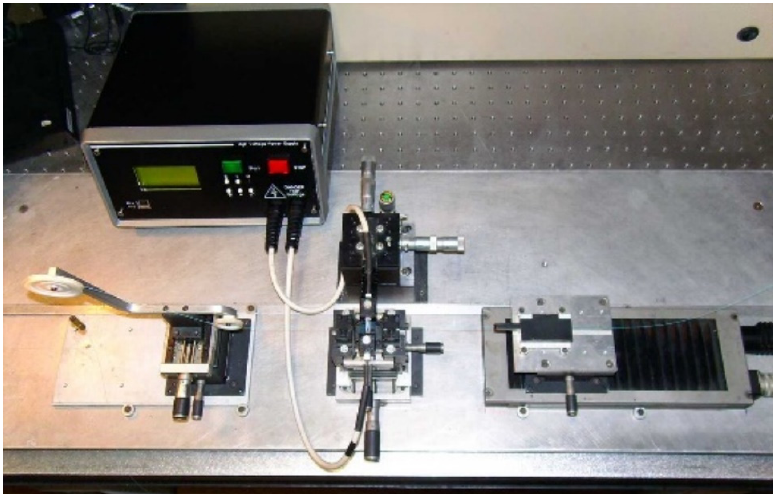
Figure 1. Experimental setup for LPFG fabrication in the dispersion turning points. Reprinted with permission from ref. [26]. © 2022 IEEE.